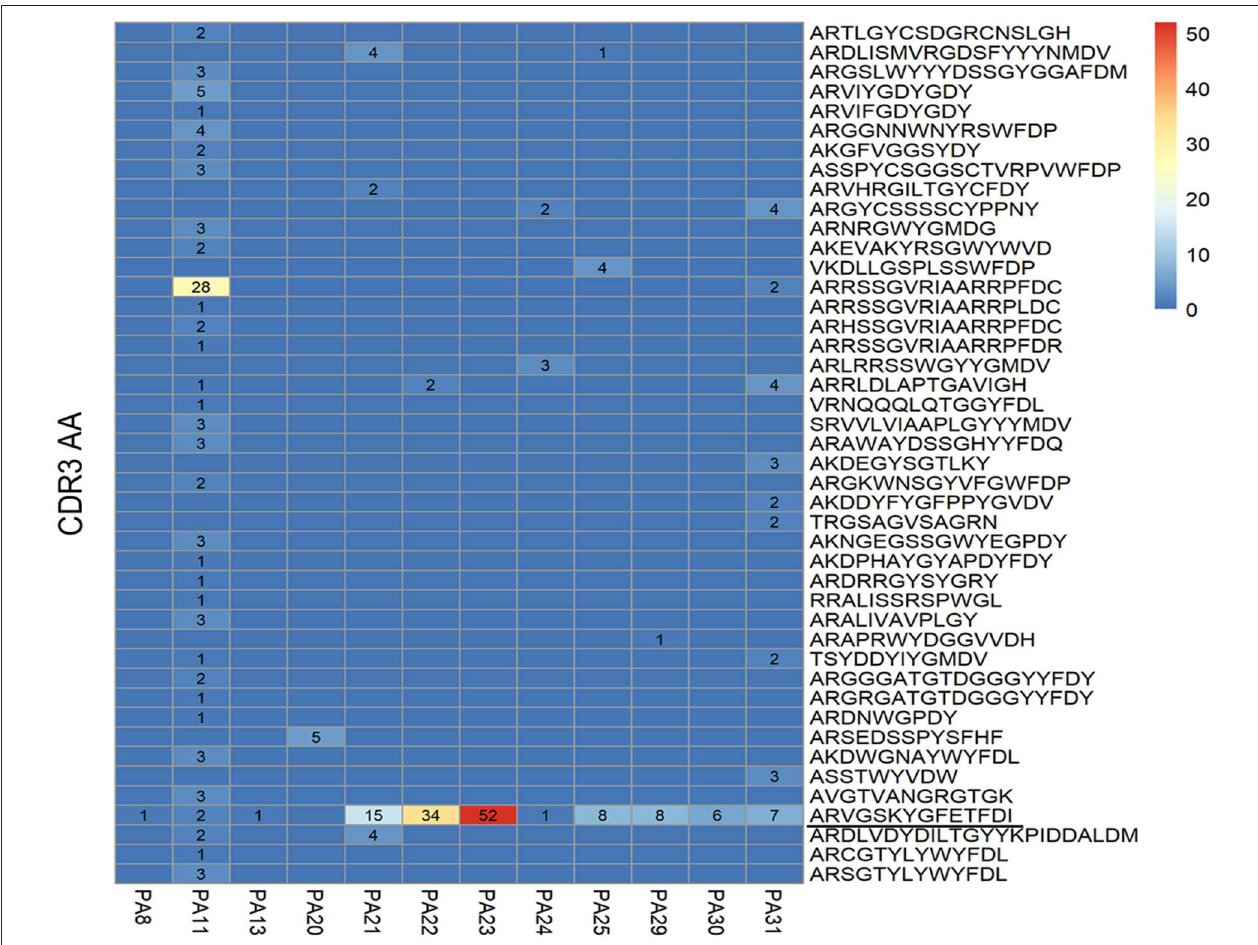
FIGURE 2 | Distribution of heavy chain clones among 12 patients with anti-NMDAR encephalitis. Heat map shows distribution of heavy chain clones among the patients. Numbers > 0 in black represent clone occurrence frequency. PA: patient ID; CDR: complementary determining region; AA: amino acid.